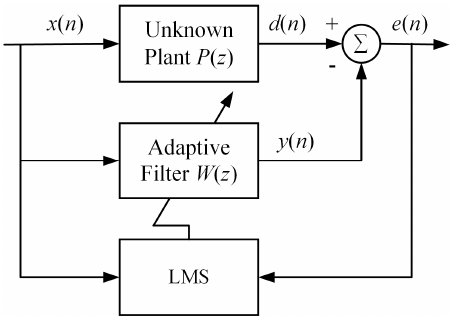
Figure 5. Schematic diagram of an active noise and vibration control system.